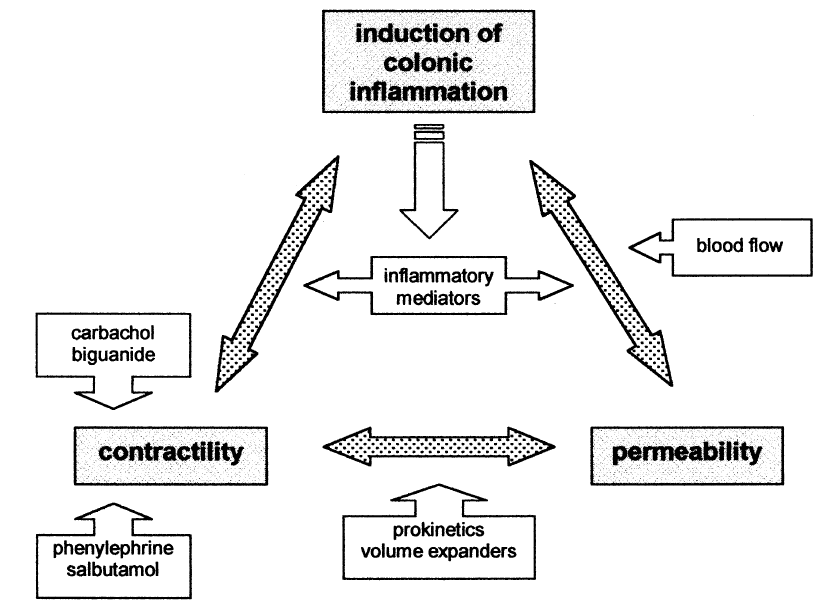
FIG. 3. Suggested interplay between colonic inflammation, contractile activity and